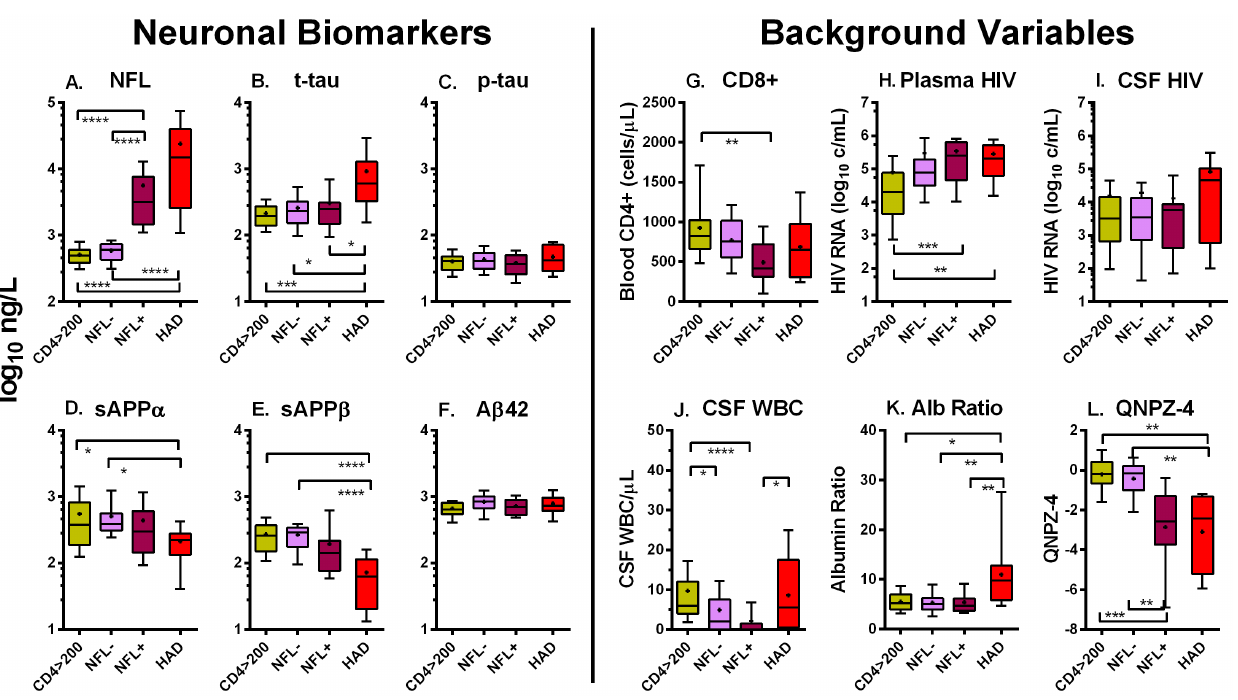
Fig. 3. Concentrations of biomarkers in redefined NA subject and HAD groups. The left 6 panels (A–F) show concentrations of six CSF neuronal biomarkers in the four redefined subject groups discussed in text using same log 10 axes as Fig. 1. The right six panels show some of the main background variables with vertical axes defined for each panel. The size of each re-sorted group was: CD , 200, N 5 40; NFL-, N 5 22; NFL + , N 5 18; HAD, N 5 12). The horizontal brackets show p values for significant group differences by Dunn’s multiple comparison test after Kruskal-Wallis test: * 5, 0.05, ** 5, 0.01, *** 5, 0.001 and **** 5,